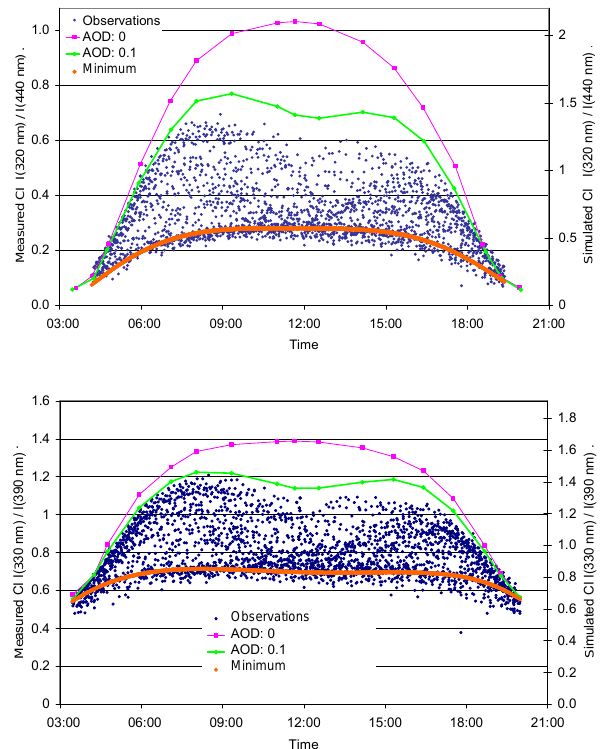
Figure 2. Comparison of measured (left axis) and simulated CI (top: 320nm/440nm; bottom: 330nm/390nm) during CINDI. The lines represent minimum values (see Fig. 1), aerosol-free conditions and low aerosol load (AOD = 0.1). The measurements are from the pe- riod 12 June to 15 July 2009; the simulations are performed for a day (26 June 2009) in the middle of the campaign. Note that the out- lier around 18:00 belongs to a spectrum of bad quality as indicated by the large residual of the spectral analysis.